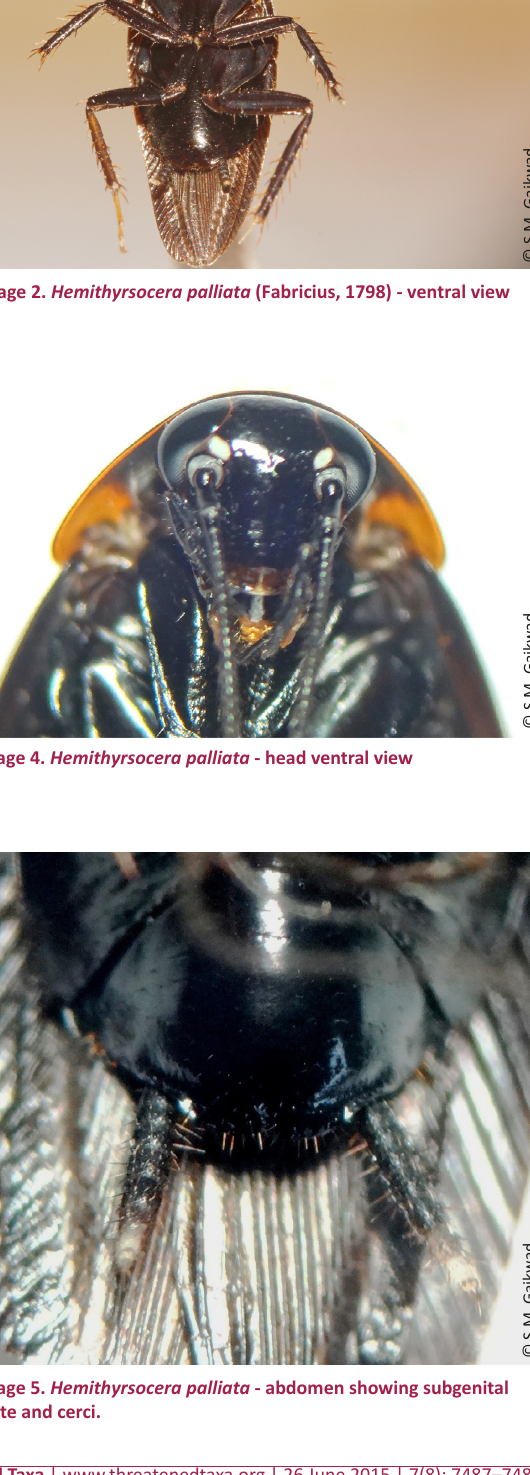
plate and cerci.